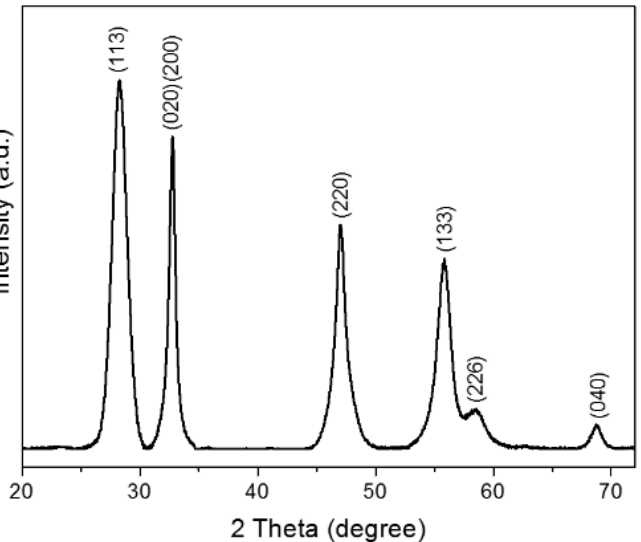
Figure 1. X-ray diffraction pattern of layered Bi 2 WO 6 nanosheets obtained by CTAB-assisted hydrothermal synthesis.